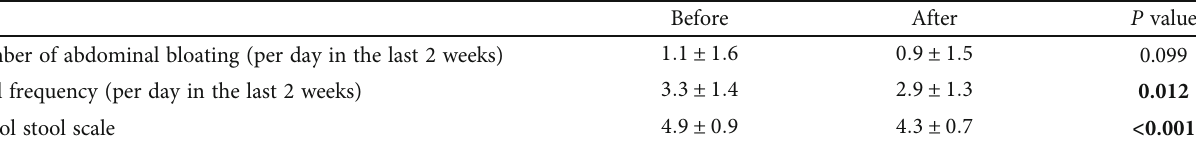
Table 2: IBS-like symptoms before and after probiotic treatment.